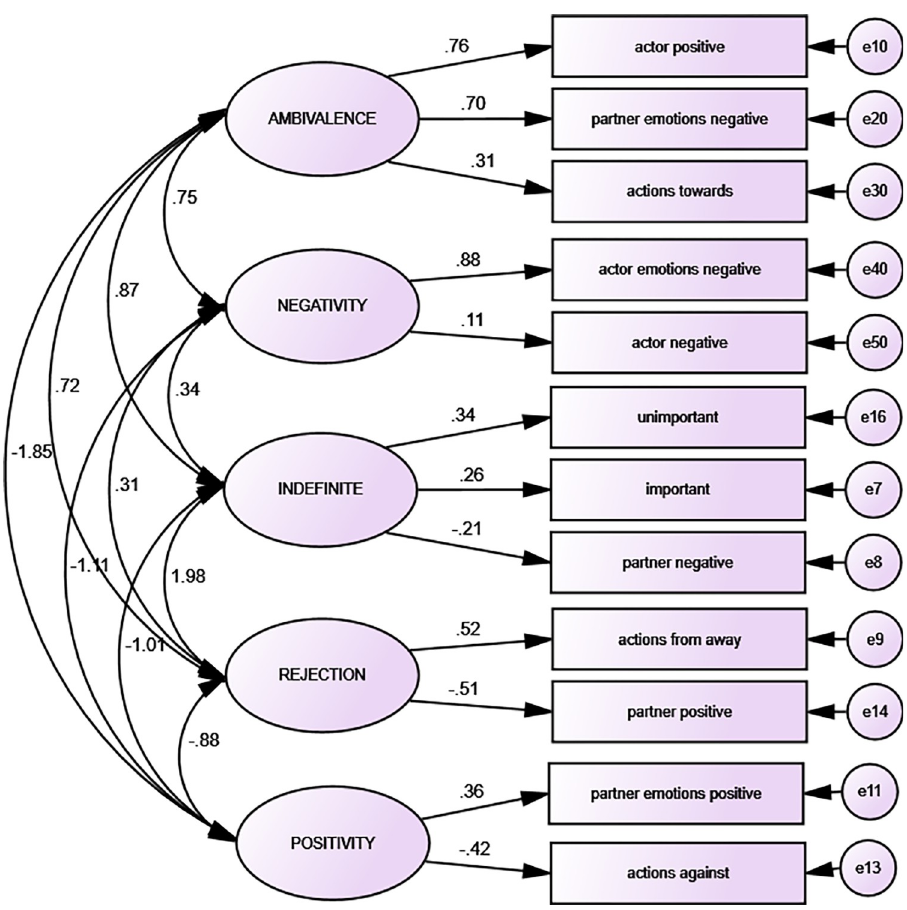
Fig 4. Anxiety: Confirmatory factor analysis (n =